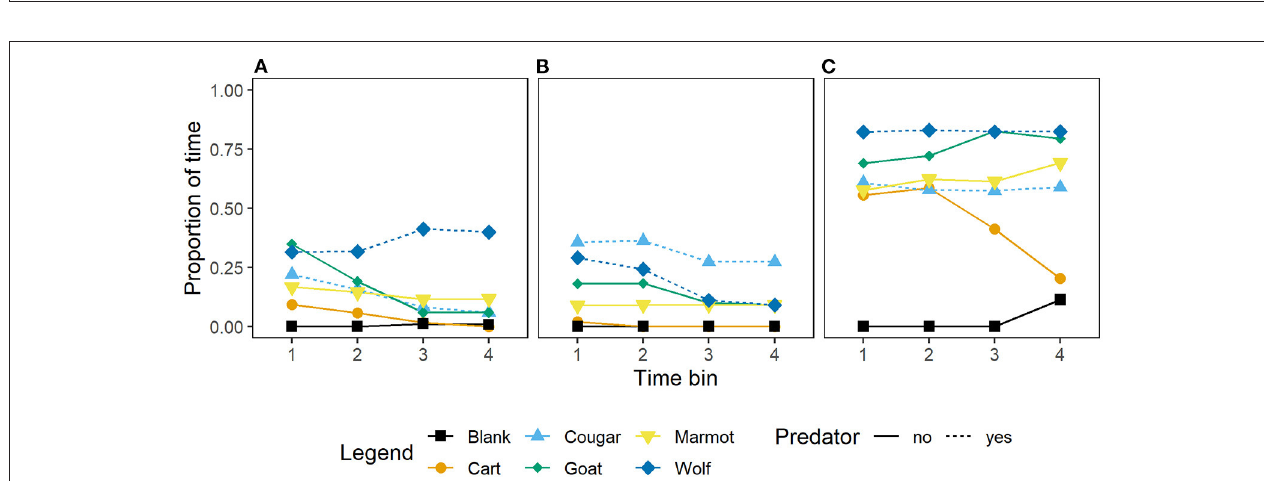
FIGURE 3 | Mean proportion of time per 15s time bin that Vancouver Island marmots ( n = 34) allocated to vigilance at the burrow or time in the burrow in response to mammal stimuli and when a blank was scored. Panels from left to right; (A) wild-caught ( n = 17), (B) captive-born 1st and 2nd generation ( n = 11), and (C) captive-born 3rd, 4th, and 5th generation ( n =